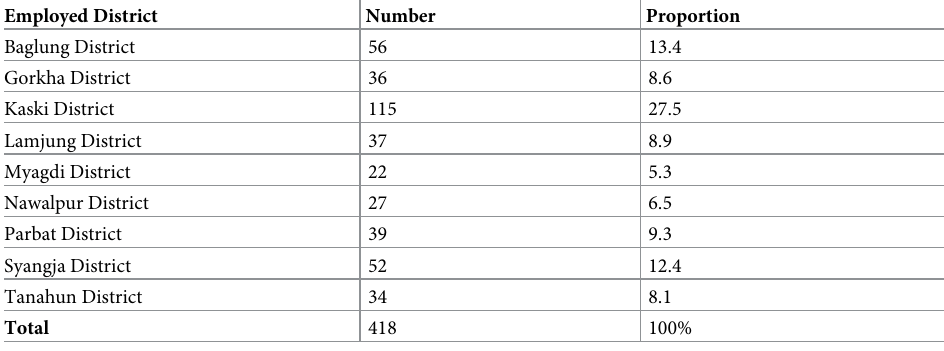
Table 1. Frequency distribution of response collected from each